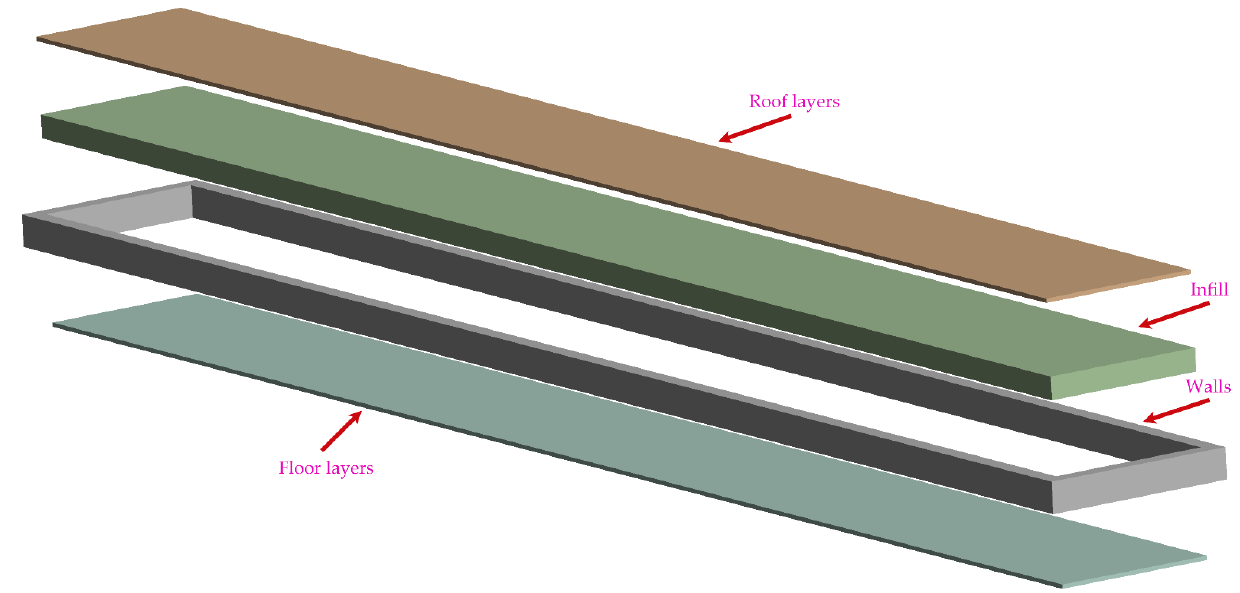
Figure 4 . Schematic sketch of printed parts. Figure 4. Schematic sketch of printed parts.